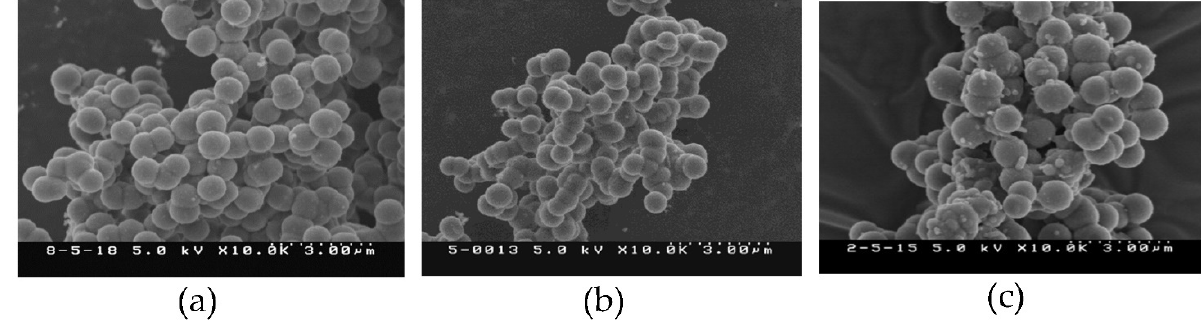
Figure 4. SEM images of precipitate: ( a ) after 24 h, ( b ) after 48 h, and ( c ) after 72 h.